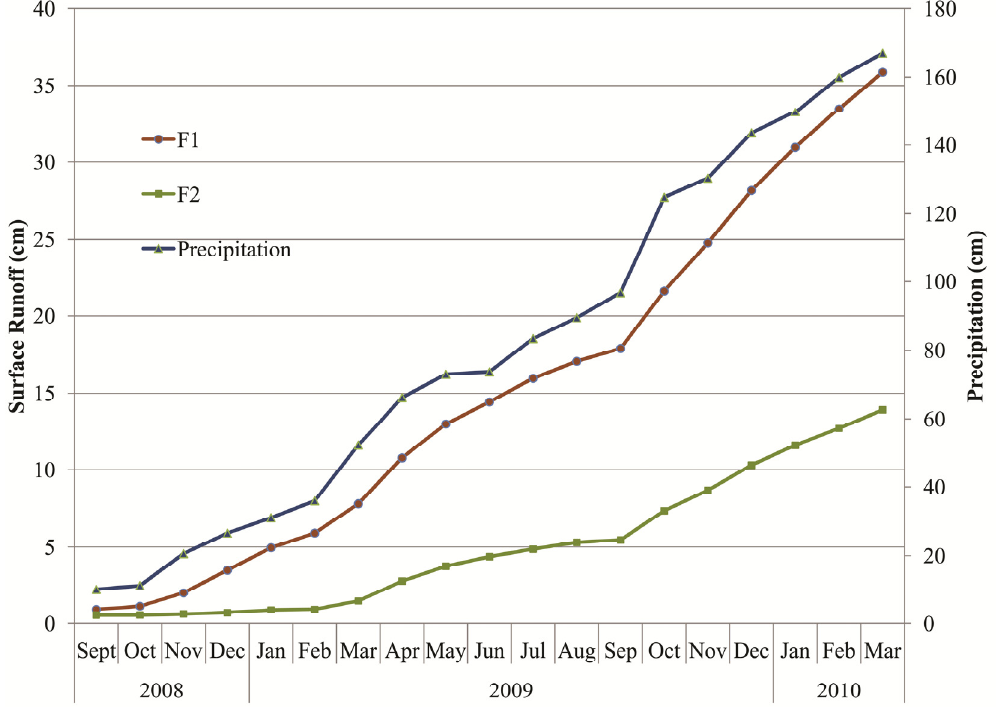
Figure 4. Cumulative ArcApex simulated water yield and rainfall for two natural gas well locations, one placed directly in the stream channel (F1) and the other offset from the channel by a 15 m buffer (F2) at the Alto Experimental Watersheds, Texas,